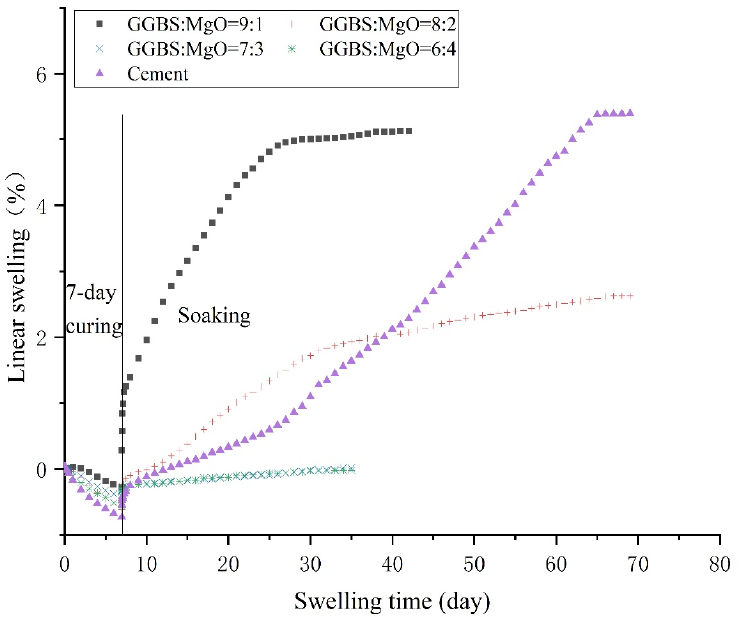
Figure 5. Vertical swelling percentages of Mg-sulfate-soil treated with cement and GGBS-MgO. Similar to Ca-sulfate-soil, Mg-sulfate-soil treated with cement showed a higher swell- ing percentage than the soil treated with GGBS-MgO, which indicated that GGBS-MgO GGBS:MgO ratio.